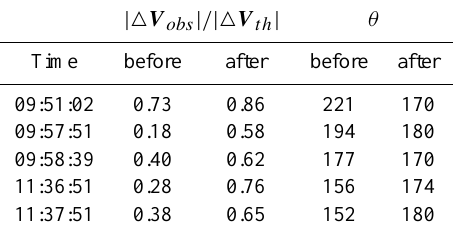
Table 1. Result of Wal´en test before and after the removal of the second population for some reconnection jets observed by